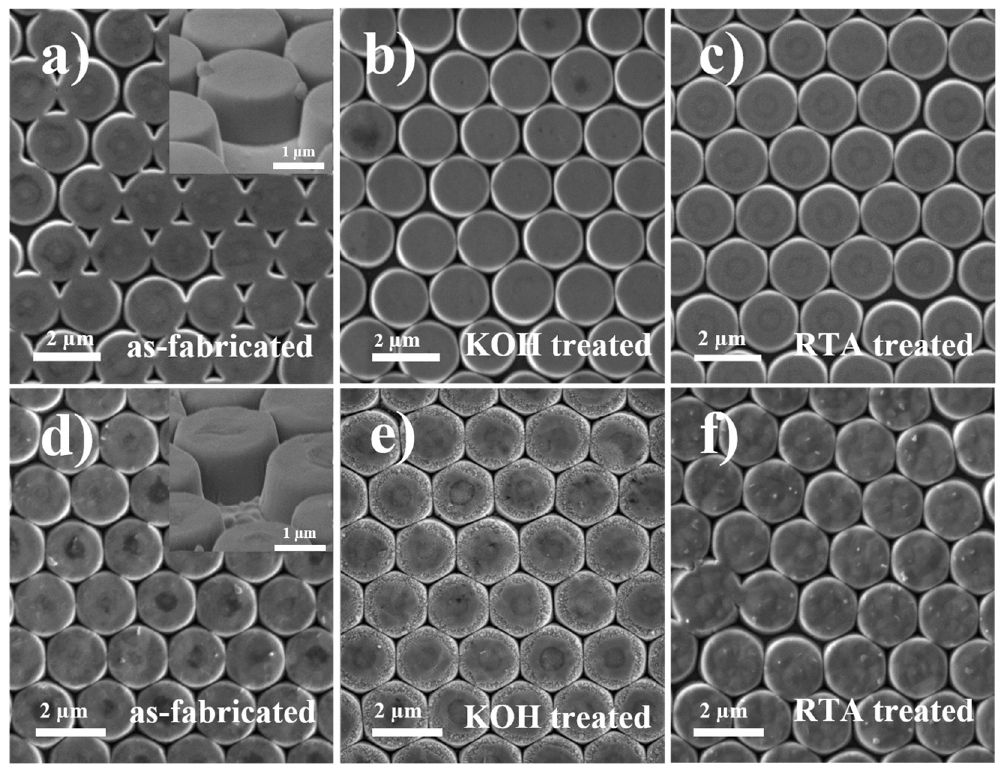
Figure 3. SEM images of III-polar ( a – c ) and N-polar ( d – f ) nanopillar multiple quantum wells (MQWs) before and after the KOH or rapid thermal annealing (RTA) treatment. Tilted-view SEM images of as-fabricated nanopillars are shown in the inset of ( a ) and ( d ).